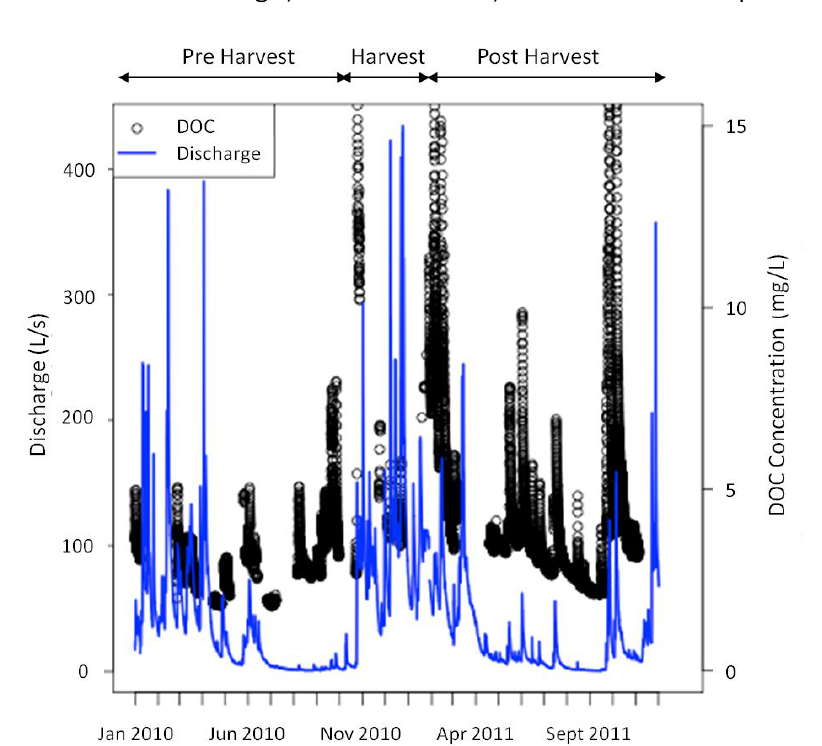
Figure 2. DOC concentration dynamics from January 2010 to November 2011 (in